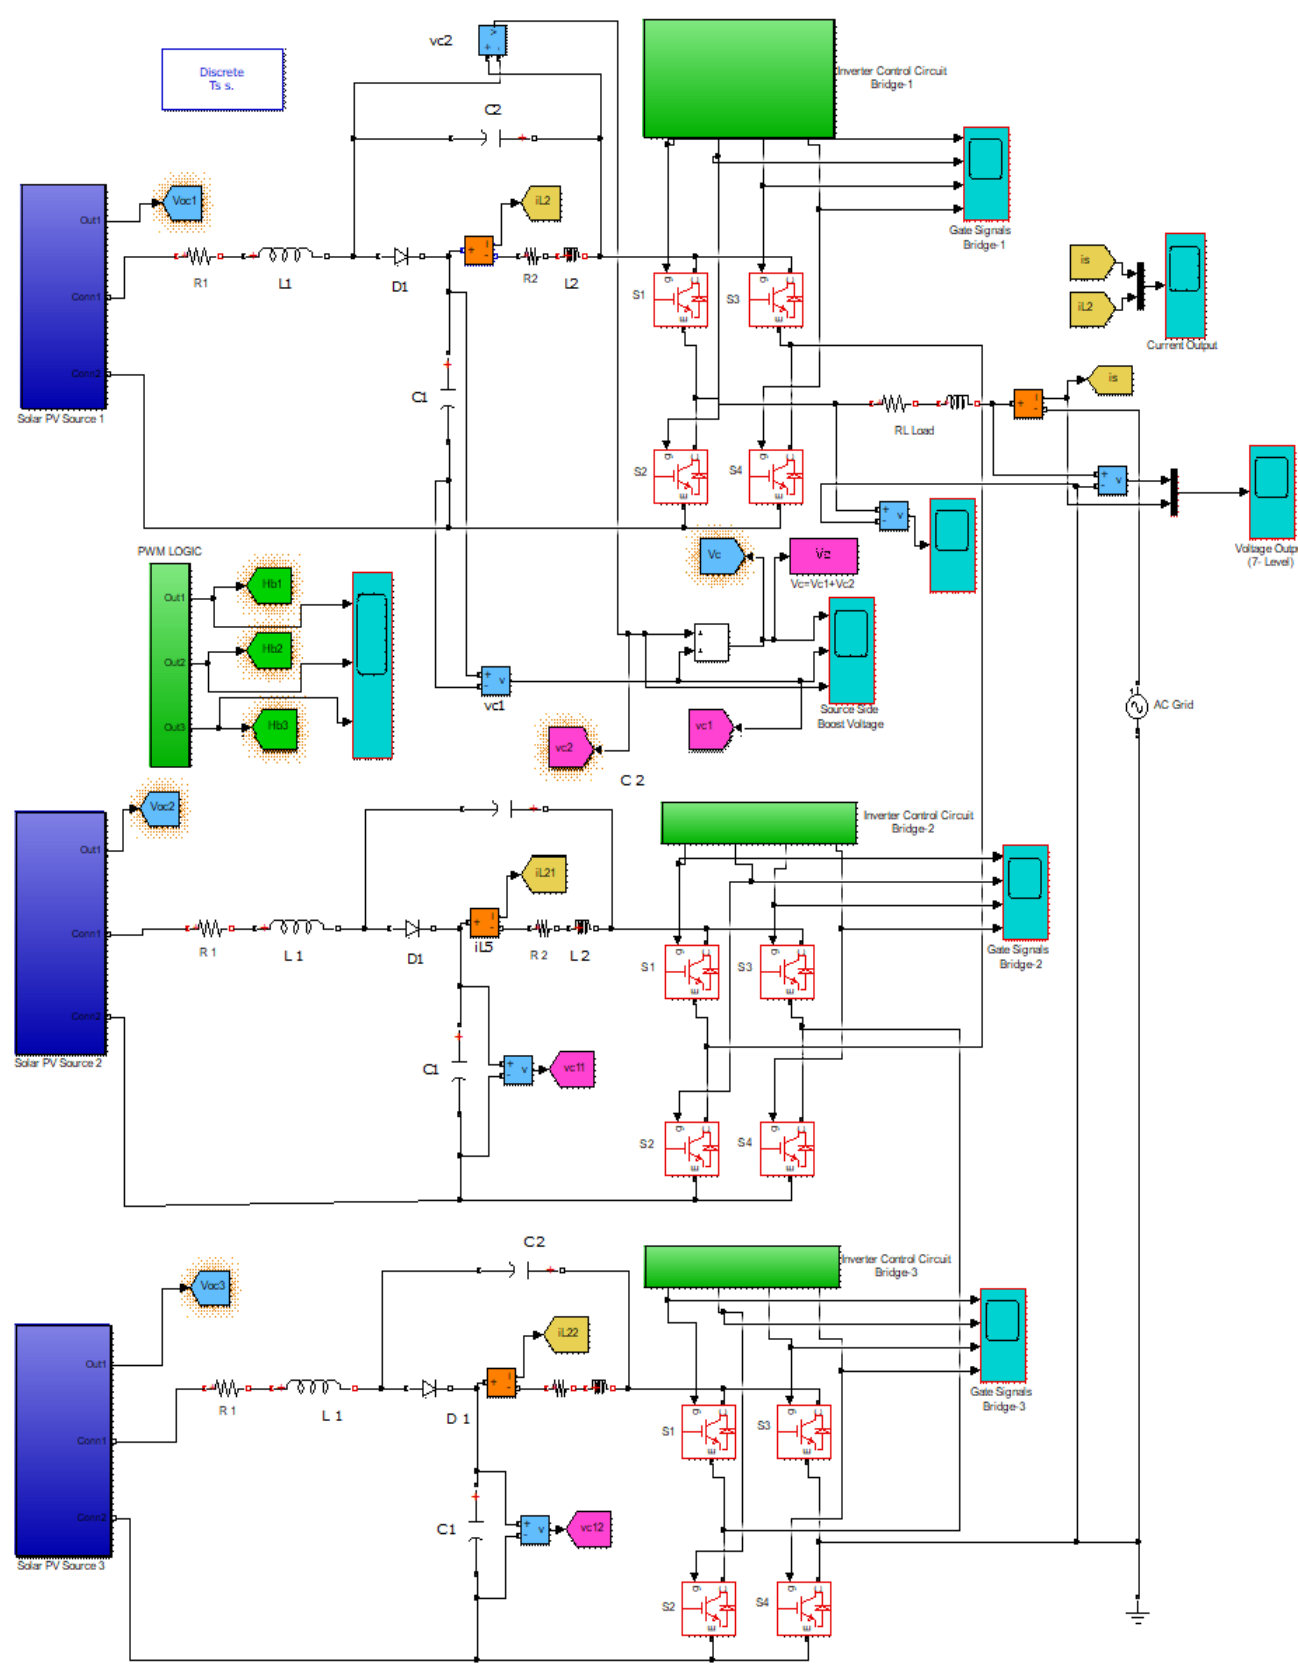
Figure 23. A complete H-bridge PV-powered qZS-CMLI modeled in Simulink.